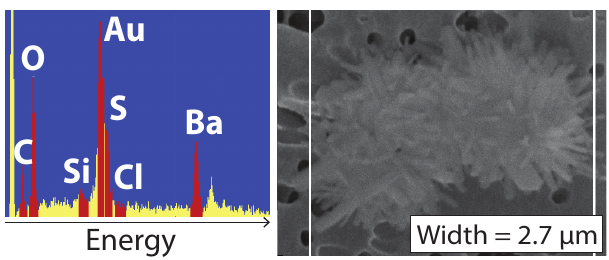
Fig. 3. EDX spectrum and SEM image of a typical BaSO 4